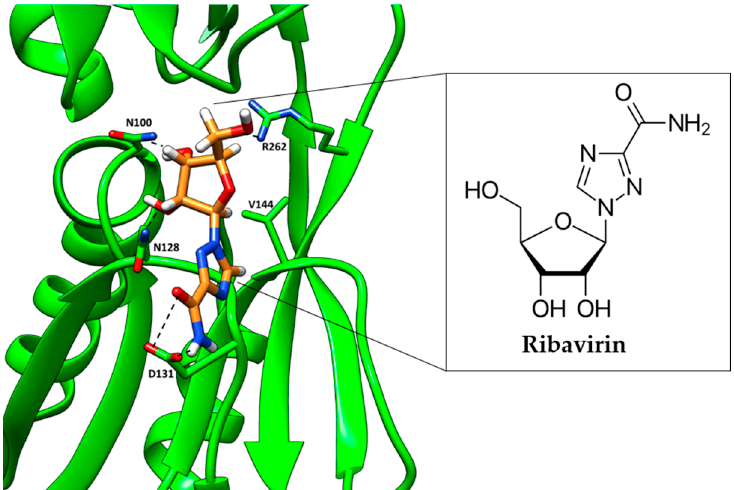
Figure 4. An inhibitor of AphB (ribavirin), discovered using LUDI, docked in the co-inducer-binding site of V. cholerae AphB (PDB ID 3SZP) [93]. The inhibitor interacts with key labeled residues; H-bonding is shown by dashed lines. Ribavirin is shown in orange, and the AphB backbone is shown as green ribbons.